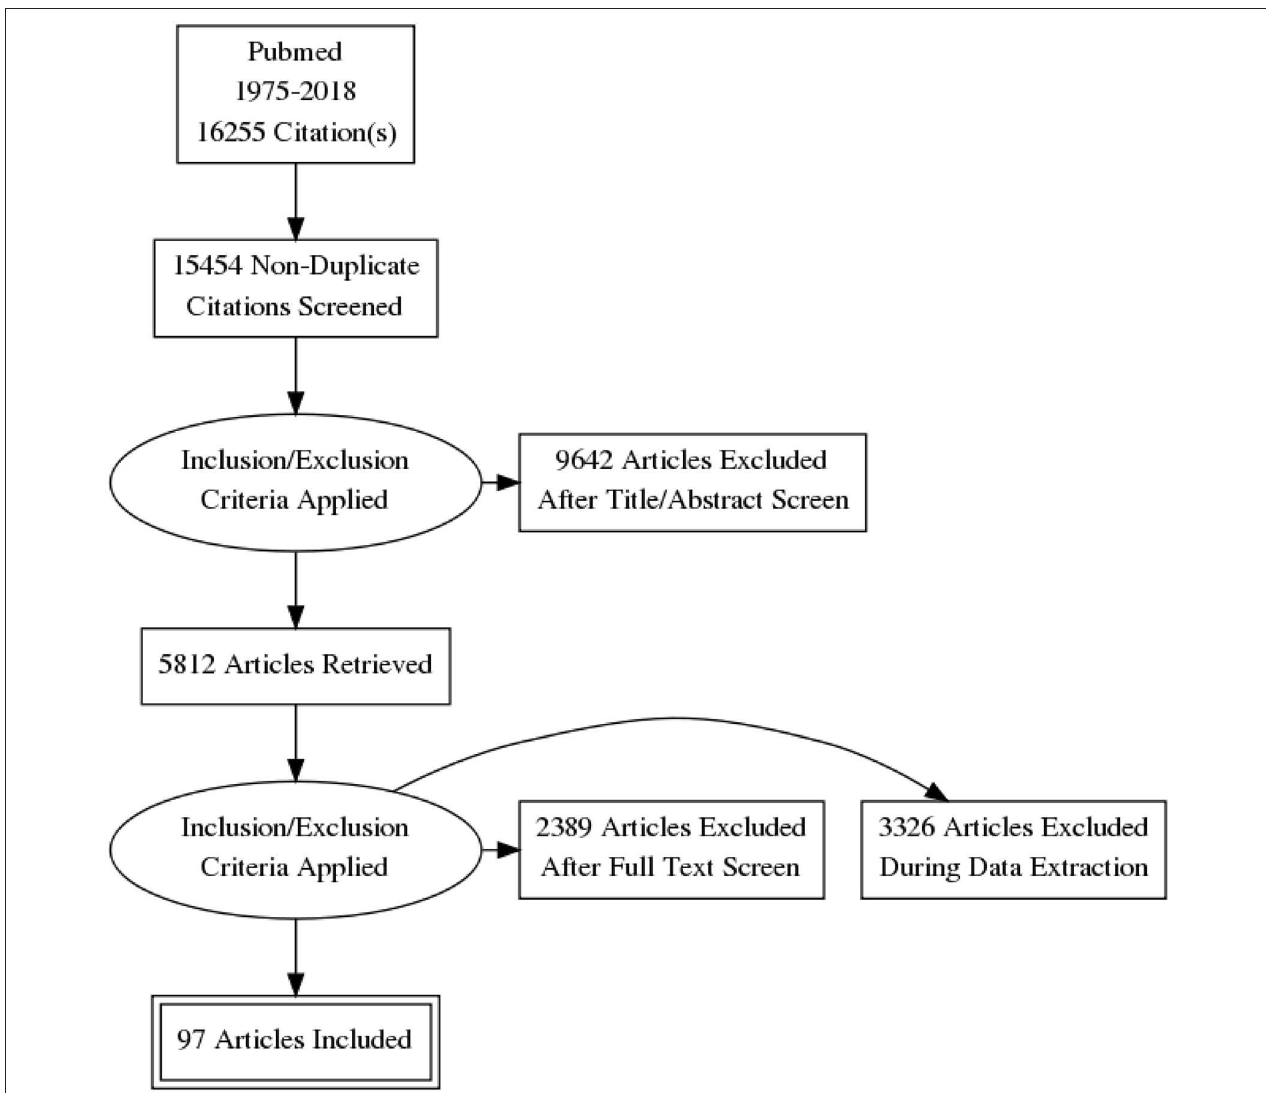
FIGURE 1 | Flow diagram showing an overview of the articles selection process.